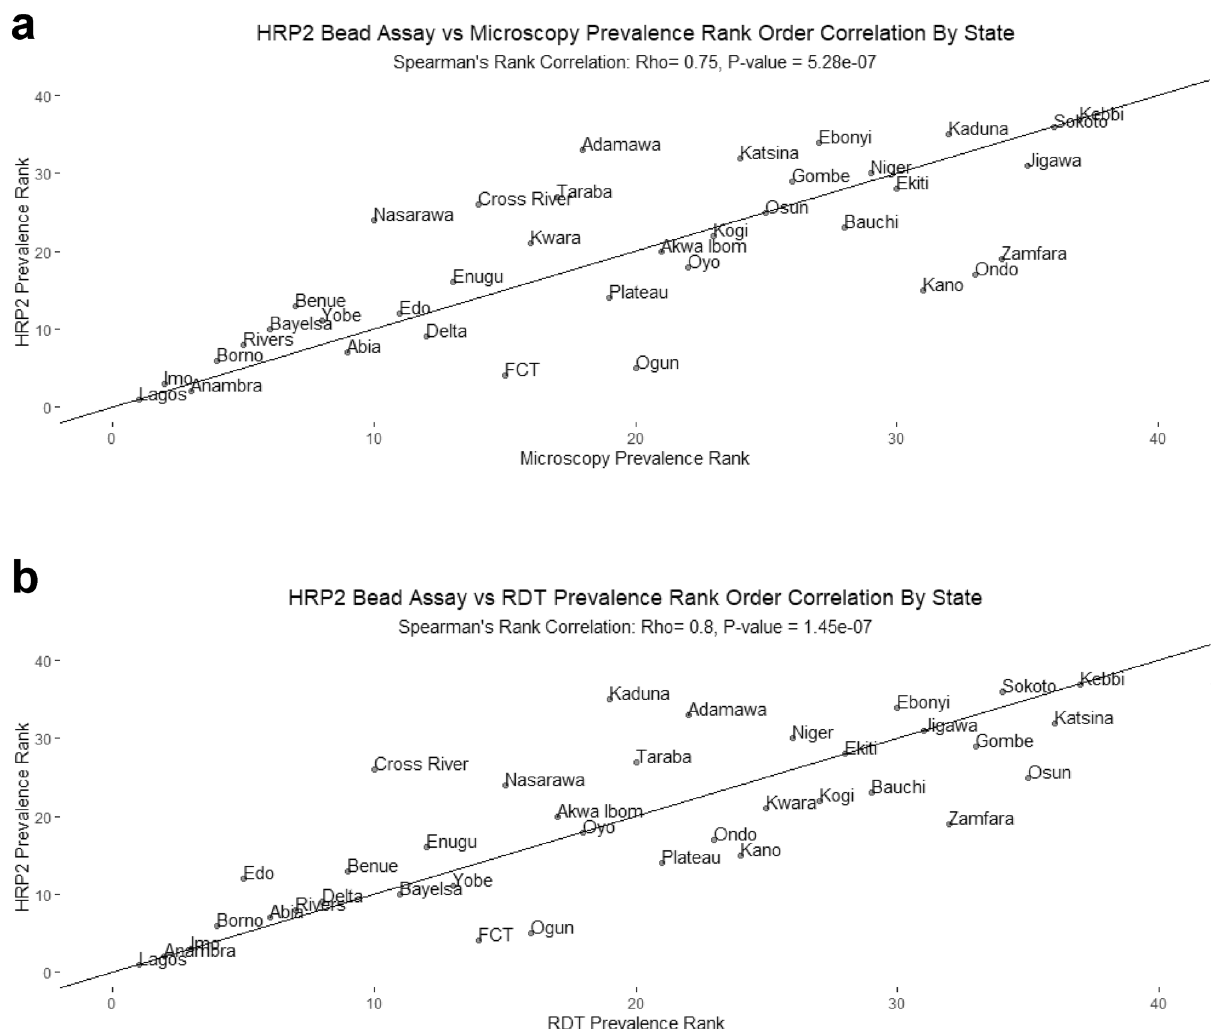
Figure 4. Concordance of prevalence rank correlation by Nigerian state. Panels display scatterplot rank of prevalence by state as well as Spearman’s rank order correlation for ( a ) HRP2 bead assay versus microscopy (Rho = 0.75, p < 0.0001 and ( b ) HRP2 bead assay versus RDT (Rho = 0.80, p < 0.0001). Higher rank denotes higher prevalence. Reference line is x =